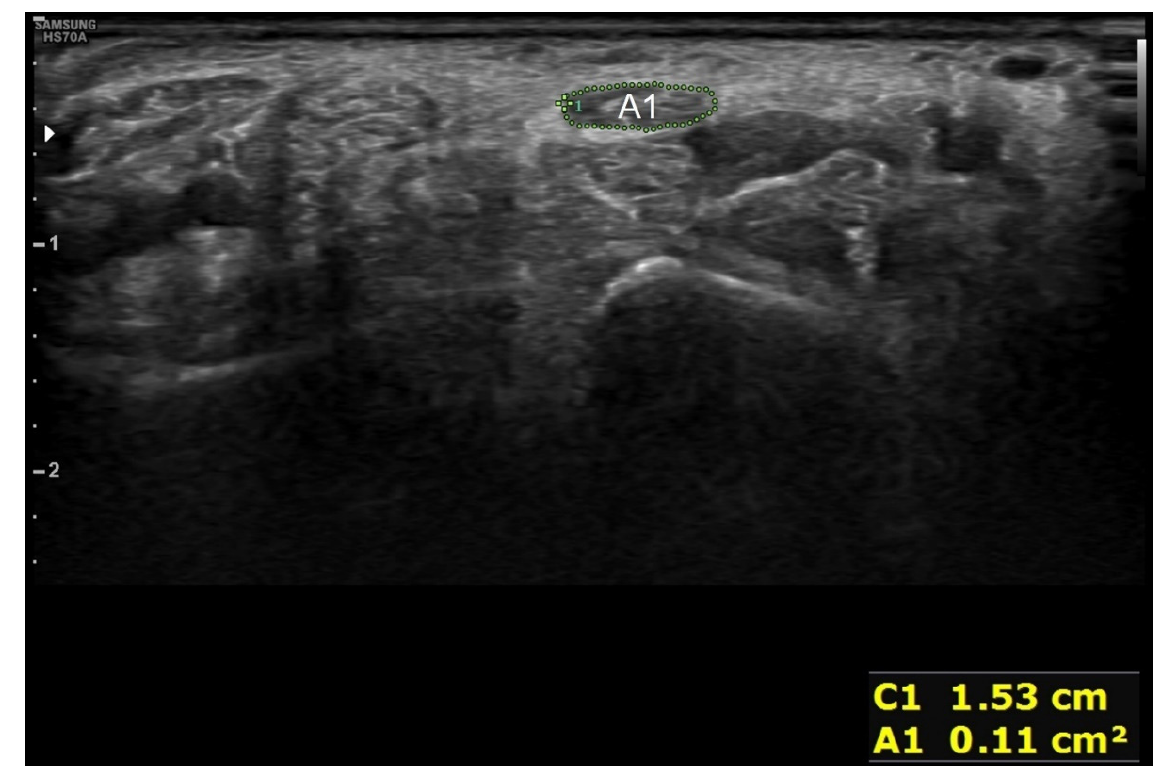
Figure 2. Diagnostic criteria for carpal tunnel syndrome by ultrasound relevant to palmar bowing of the flexor retinaculum. The yellow dot line of D1 shows a line connecting the top of the pisiform and the scaphoid bone. D2 is the distance from D1 to the transverse carpal ligament.